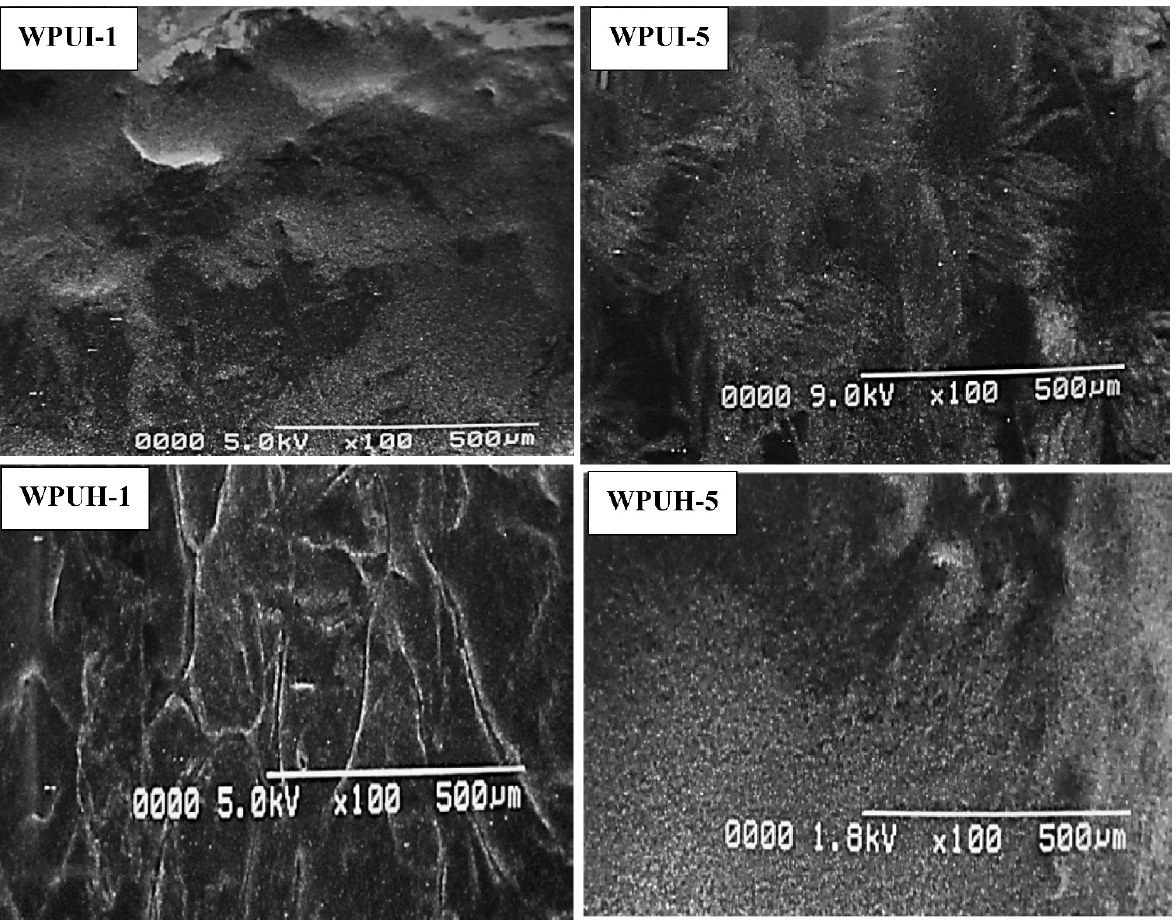
Figure 4. SEM micrographs of WPUI-1, WPUI-5, WPUH-1, and WPUH-5. The dark areas represent the soft segments, and the bright areas represent the hard segments. All images show a magnification of 100× with a resolution of 500 μ m.